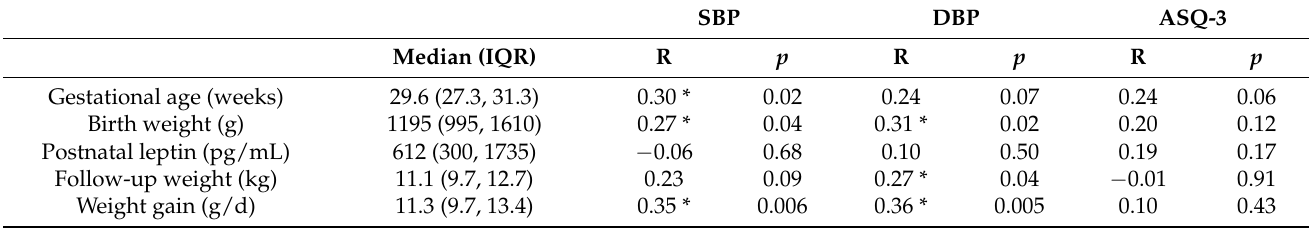
Table 2. Systolic blood pressure (SBP, N = 58), diastolic blood pressure (DBP, N = 58) and total score on the Ages & Stages Questionnaire (ASQ-3, N = 66) were correlated by univariate linear regression with maternal and infant variables, including the postnatal leptin levels obtained at 35-week PMA.